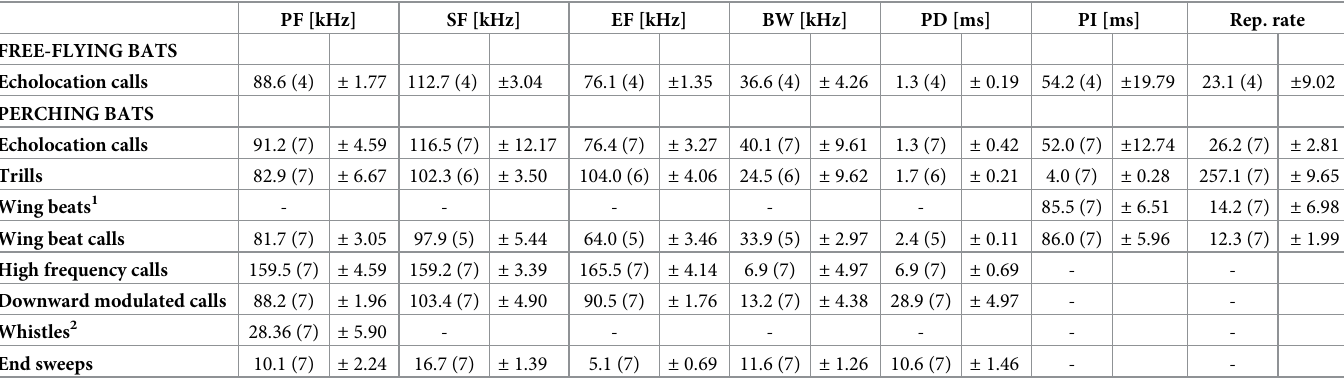
Table 1. Analysis of vocalizations of free-flying and perching